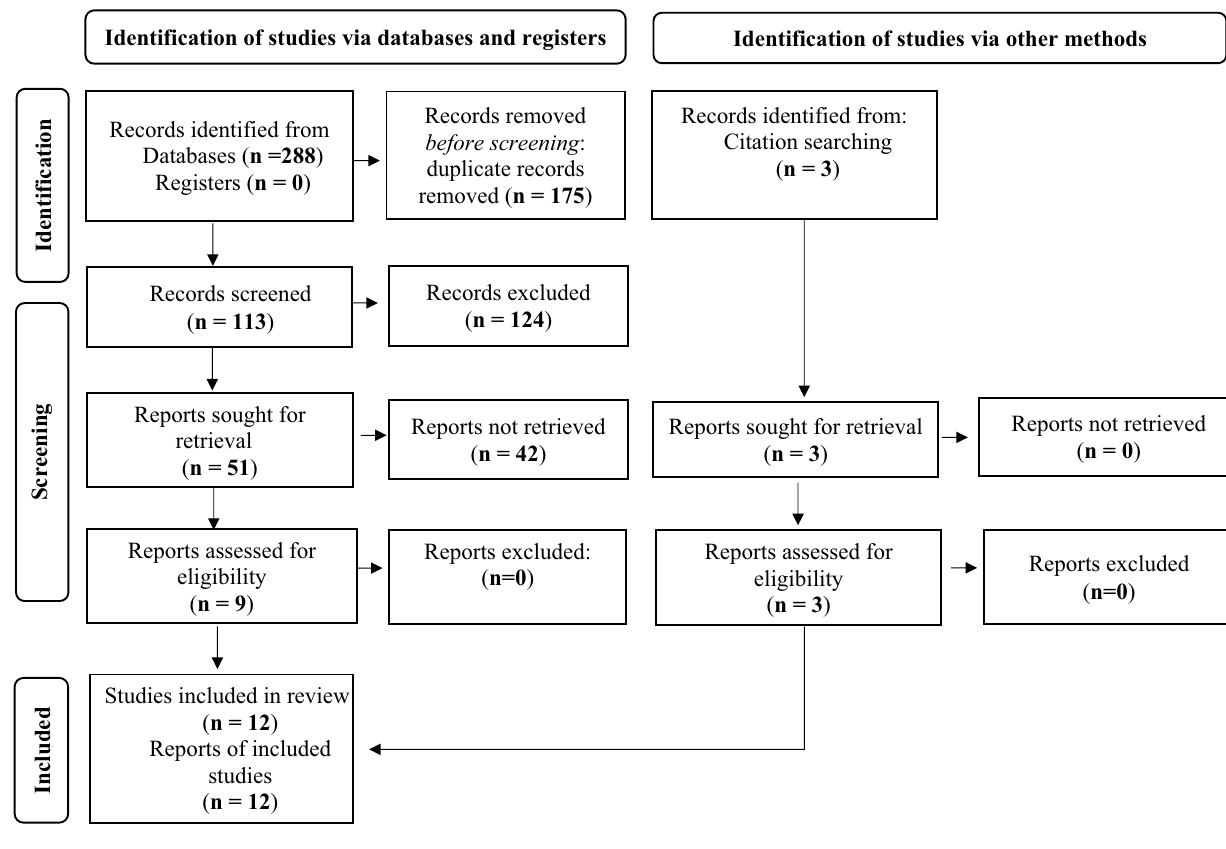
Fig. 1 PRISMA flow diagram of included